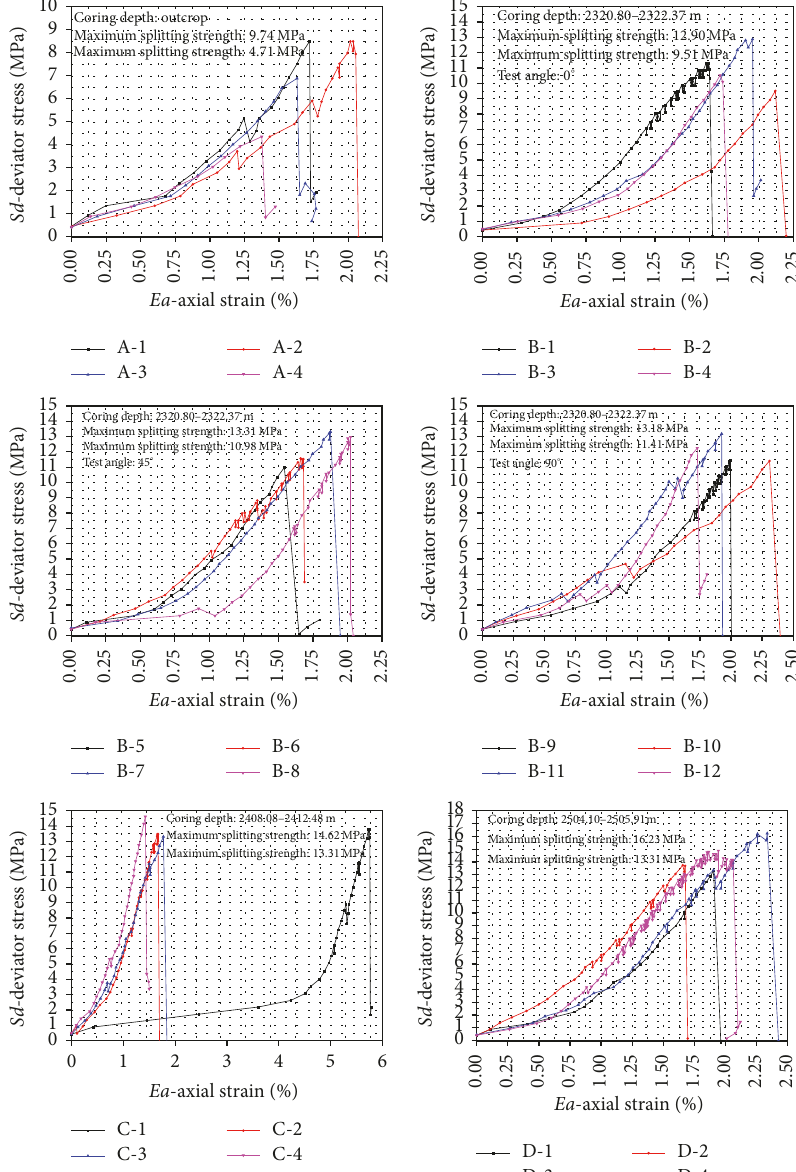
Figure 6: Stress-strain curves of the Brazilian splitting